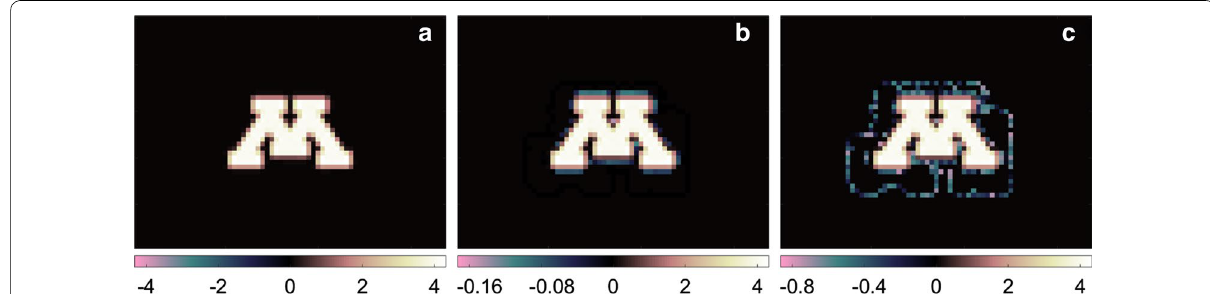
Fig. 1 Known magnetic source distributions for scenarios 1 and 2 ( a ), scenarios 3 and 4 ( b ), and scenarios 5 and 6 ( c ). Note the nonlinear colorbar spacing in b and c . The field of view for each image is 6.7 mm × 5 mm, dipole orientation is out of page, and units are Am 2 for all images